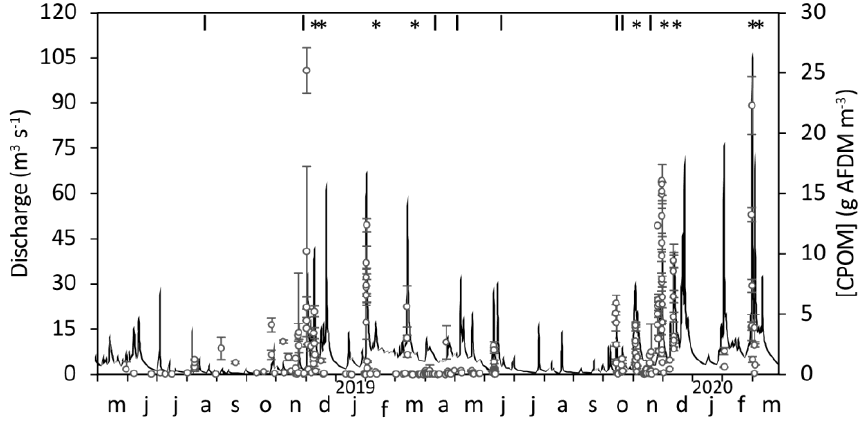
Figure 3. Variations of mean ± SD CPOM concentration (g AFDM m −3 , gray open dots) and discharge (m 3 s −1 ) (black line) during the study period. Vertical dashes indicate monitored minor flow events. Asterisk indicate monitored major flow event (Q > 30 m 3 s −1 ).